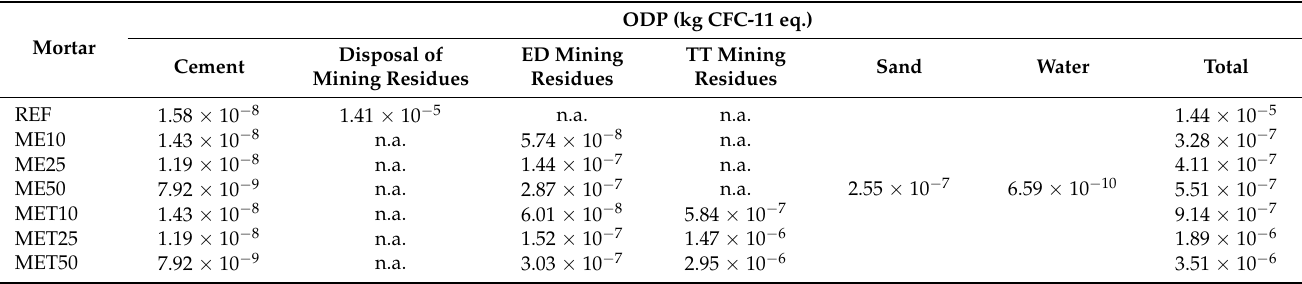
Table A3. Environmental impacts in the Ozone Depletion Potential category, from the production of 1 t of mortars with cement and treated mining residues as binder constituents.